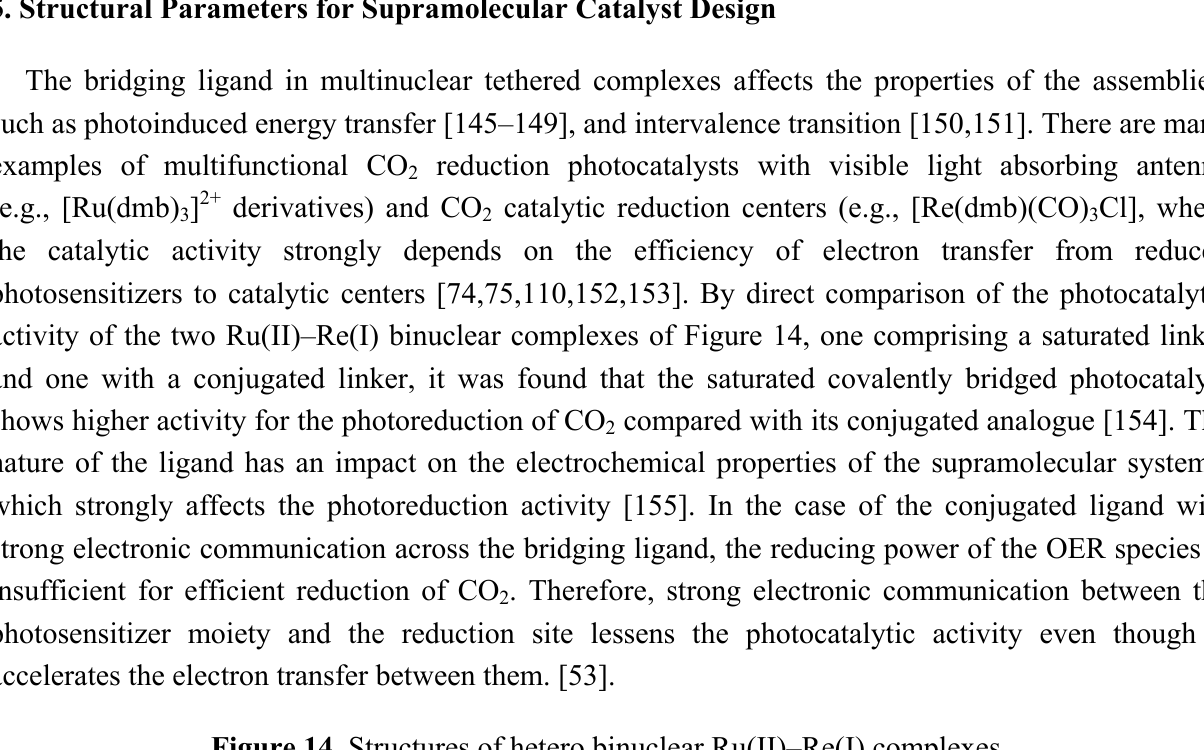
Figure 14. Structures of hetero binuclear Ru(II)–Re(I)